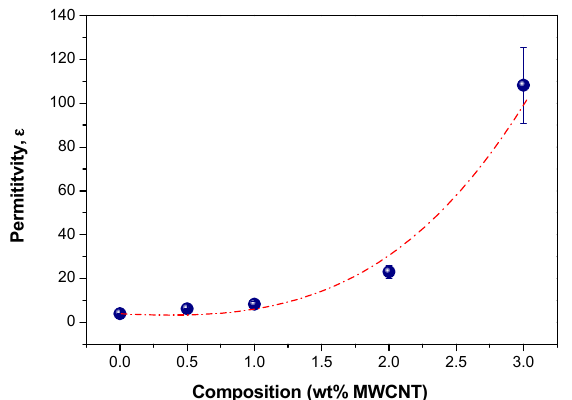
Figure 8. Permittivity (calculated from Equation (5)) as a function of MWCNT content.